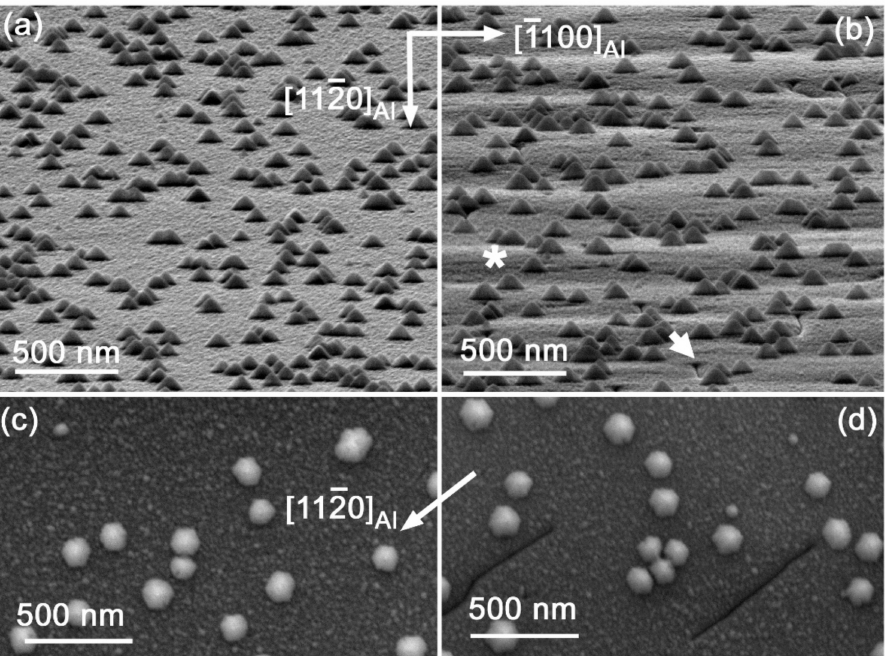
Figure 1. SEM images of the In(Ga)N layers grown on the on-axis ( a , c ) and off-axis ( b , d ) GaN/Al 2 O 3 substrates. ( a , b ) Images were taken with sample tilted by 85 ◦ from the surface normal; ( c , d ) are the plane-view images oriented according to the shown direction of Al 2 O 3 substrate. The asterisk * in ( b ) denotes clearly visible steps related to the off-axis substrate; the thick short arrow points to one of the observed